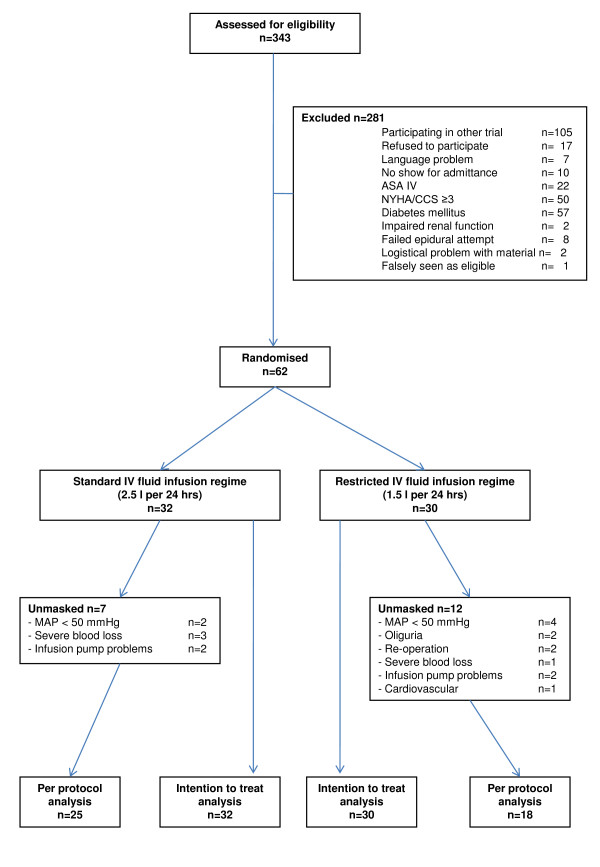
Flow chart of patient inclusion, follow-up, and analysis.